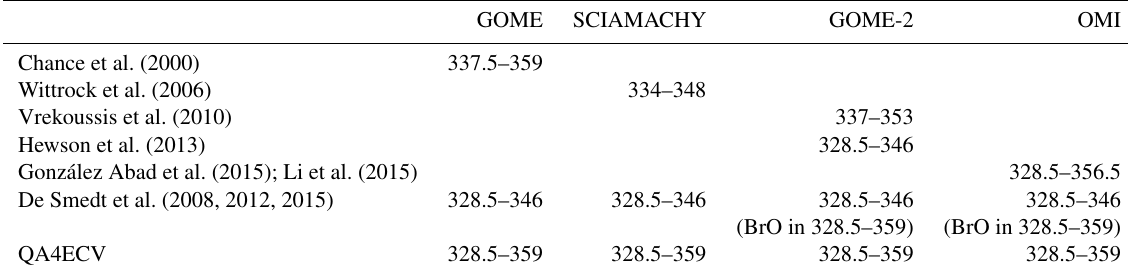
Figure 4. Typical optical densities of HCHO, O 3 , O 2 -O 2 , BrO, Ring effect, and NO 2 in the near UV. The slant columns have been taken as 1.3 × 10 16 moleccm − 2 for HCHO, 10 1 9moleccm − 2 for O 3 , 0.4 × 10 4 3molec 2 cm − 5 for O 2 -O 2 , 10 1 4moleccm − 2 for BrO, and 1 × 10 16 moleccm − 2 for NO 2 . A ratio of 8% has been taken for Raman scattering (Ring effect). High-resolution absorption cross sec- tions of Table 2 have been convolved with the TROPOMI ISFR v1.0 (row 1 is shown in red and row 225 in black; see also Fig. 5). The two fitting intervals ( − 1 and − 2) used to retrieve HCHO slant columns are limited by grey areas. Table 3. Wavelength intervals used in previous formaldehyde retrieval studies